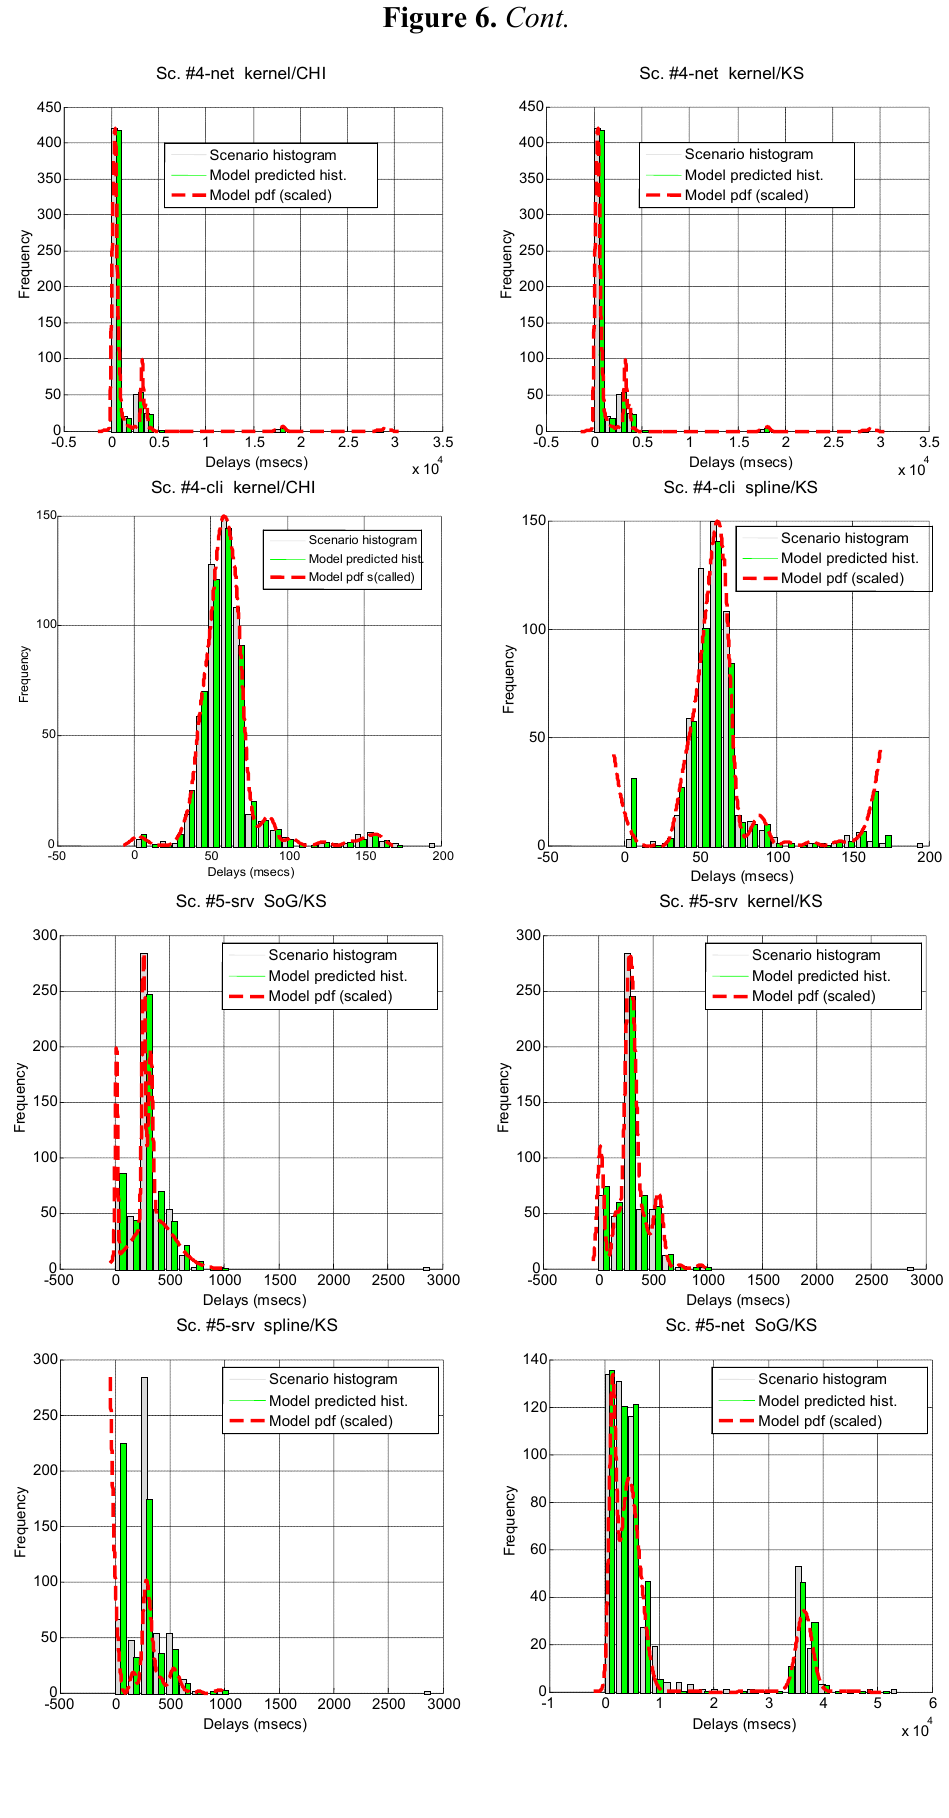
Scenario histogram Model predicted hist.